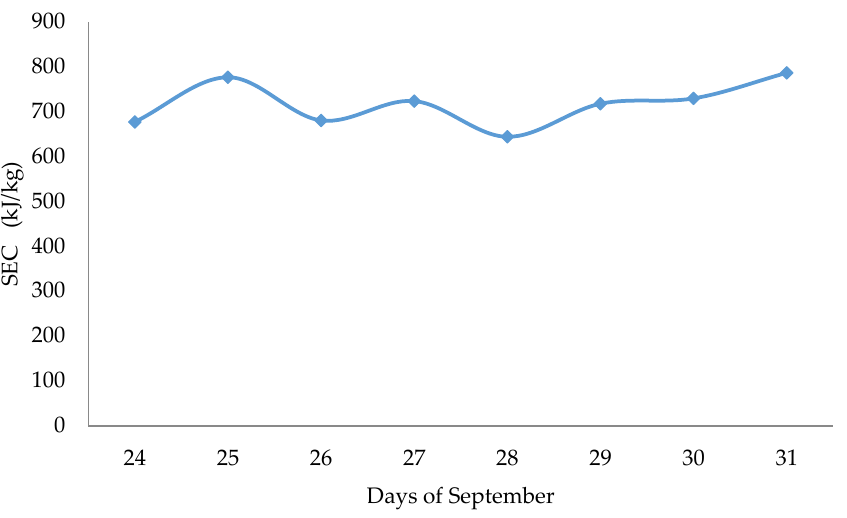
Figure 10. Measured performance ratio for the solar MSF system between 21 and 31 September.